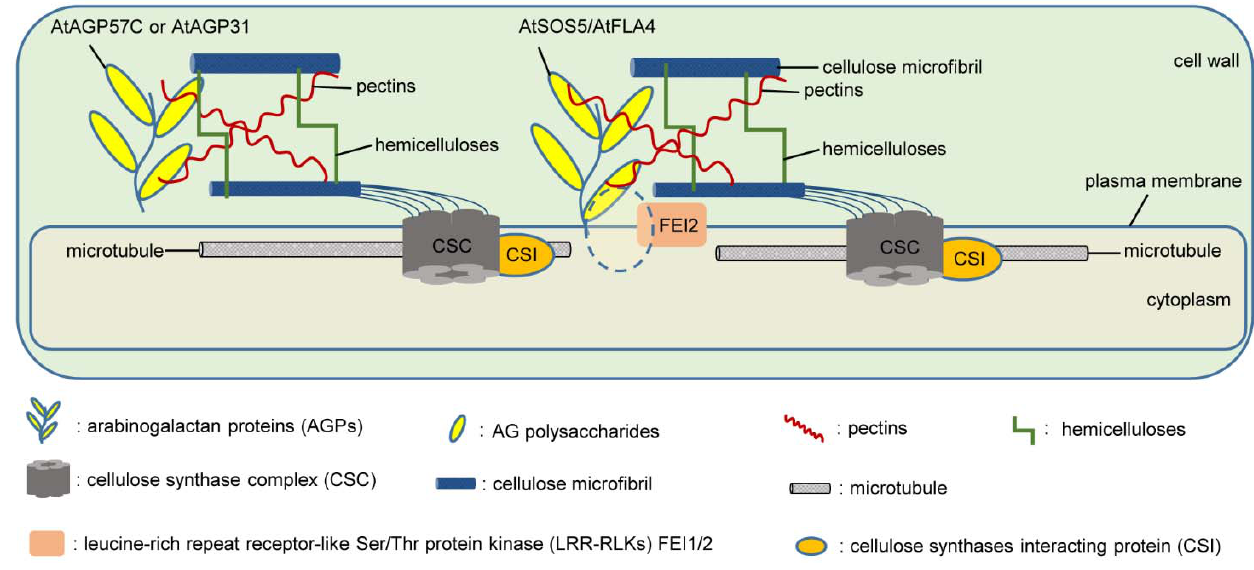
Figure 2. A hypothetical model of AGPs as structural components affecting cellulose deposition through interconnections with other cell wall components, such as hemicelluloses and pectins. AtAGP57C covalently attaches to hemicellulosic and pectic polysaccharides, as proposed by Tan et al. for the APAP1 complex [96]. Noncovalent networks between AtAGP31 and cell wall polysaccharides refer to Hijazi et al. [103]. AtSOS5/AtFLA4 and pectin interconnections in a FEI2-dependent manner are represented according to [112,113,165].